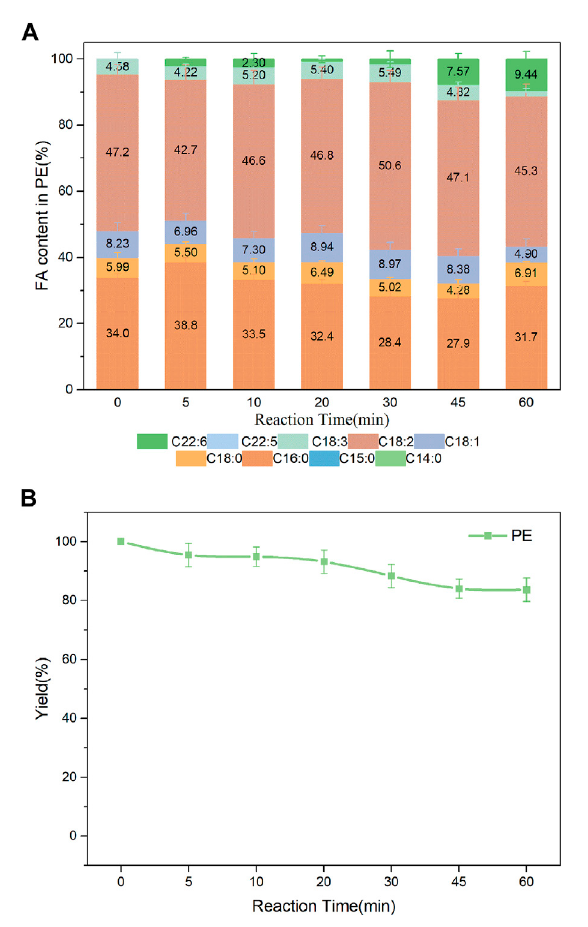
FIGURE 8 (A) Pro fi les of FA in the product PS; (B) Yield of the product in PLA1-mediated transesteri fi cation of PS with DHA-TAG; Reaction conditions: 20 mg PS, 1.0 g algae oil, 10 µL PLA1, 45 ° C, 500 rpm.